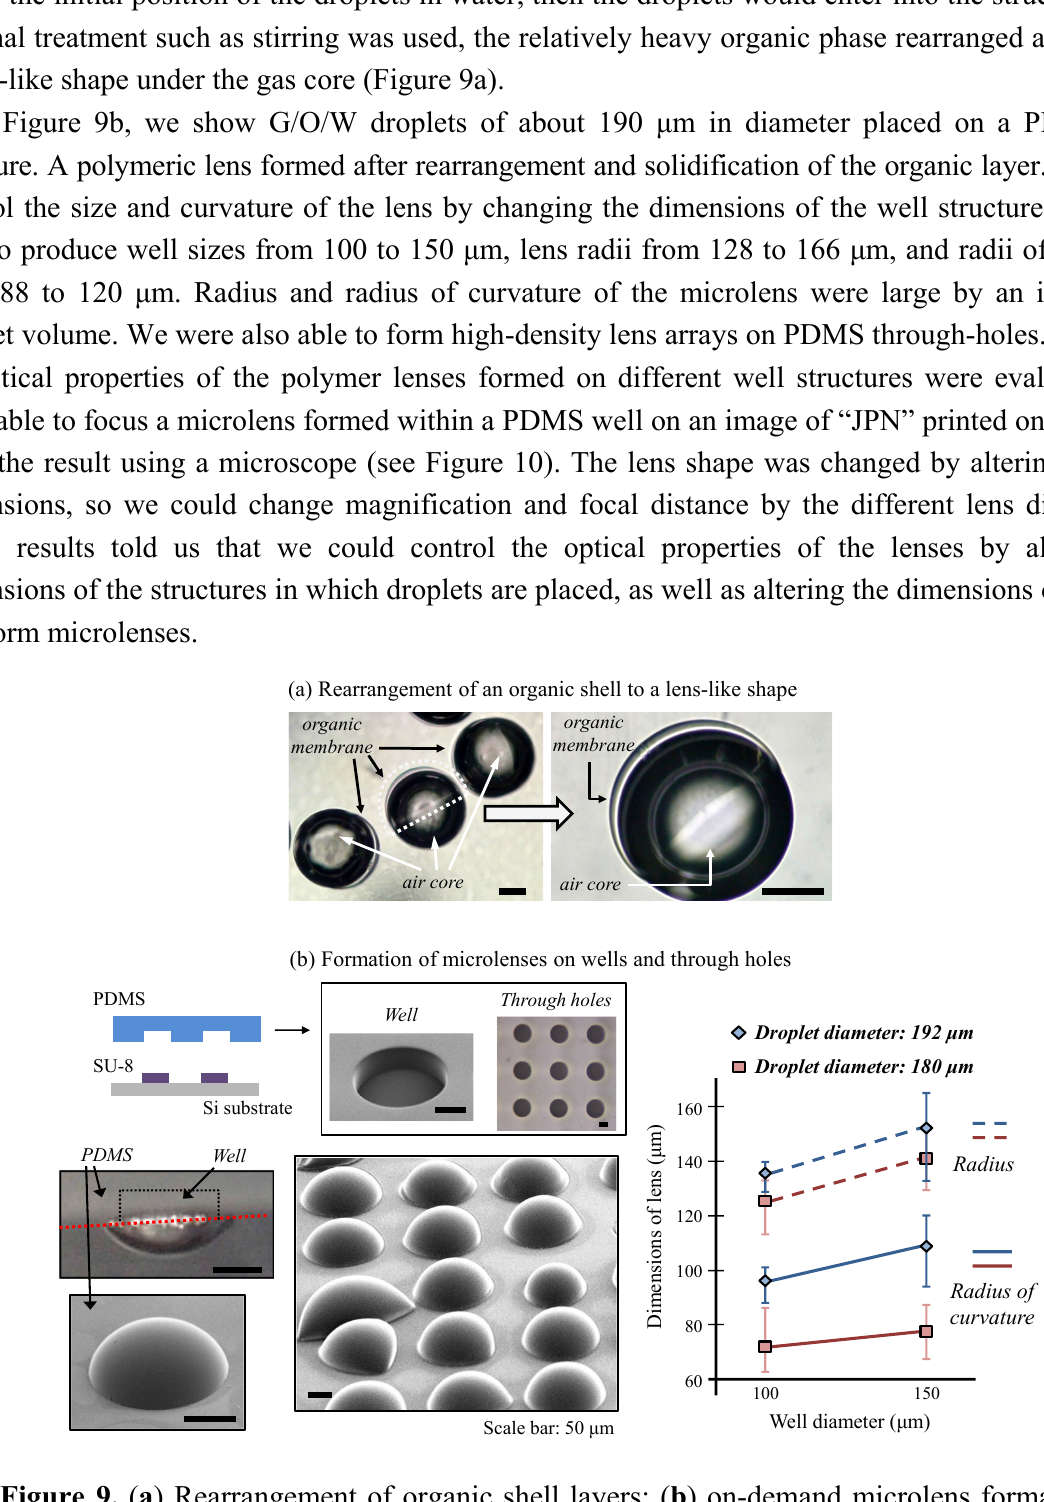
Figure 9. ( a ) Rearrangement of organic shell layers; ( b ) on-demand microlens formation on a polydimethylsiloxane (PDMS)